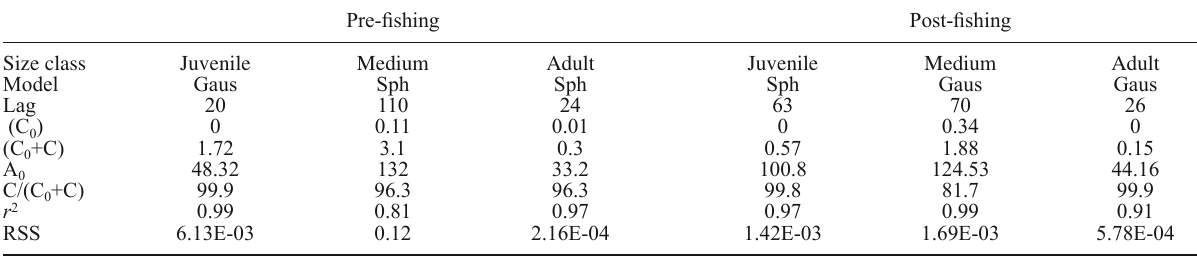
, nugget effect; C +C, sill; A (in metres), range; C/(C +C) (in 0 0 0 0